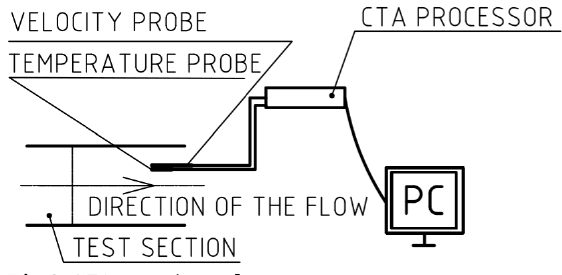
Fig. 3. CTA experimental setup .